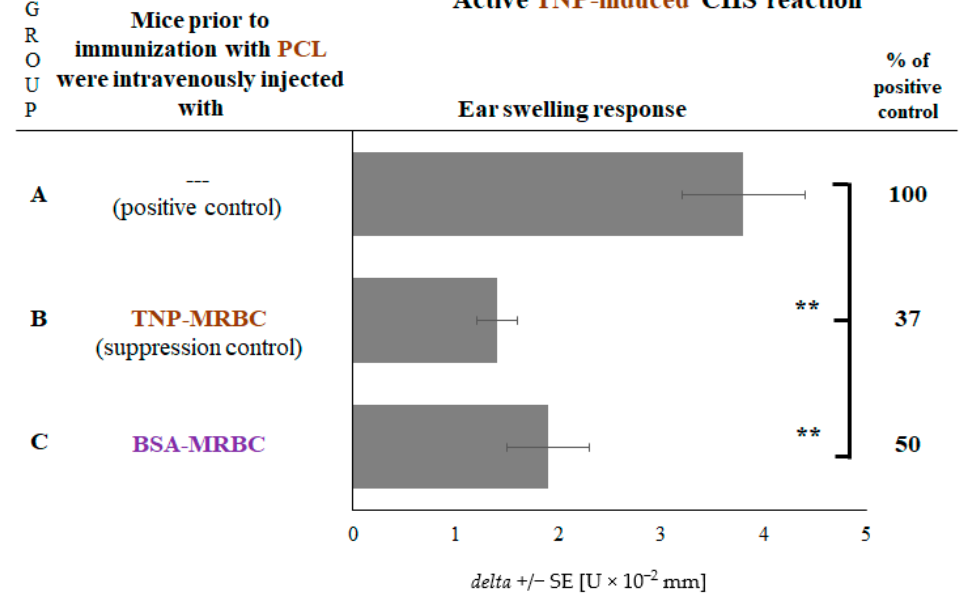
Figure 4. Effects of intravenous administration to CBA mice of a high dose of bovine serum albumin (BSA)-coupled syngeneic mouse red blood cells (MRBC) on contact hypersensitivity (CHS) reaction to TNP-chloride (PCL) or OX hapten. CHS reaction was measured as ear swelling response in actively sensitized mice that had been administered with BSA-MRBC prior to sensitization with PCL. Bars express delta ± standard error (SE). n = 5 mice in each group. ** p < 0.01.